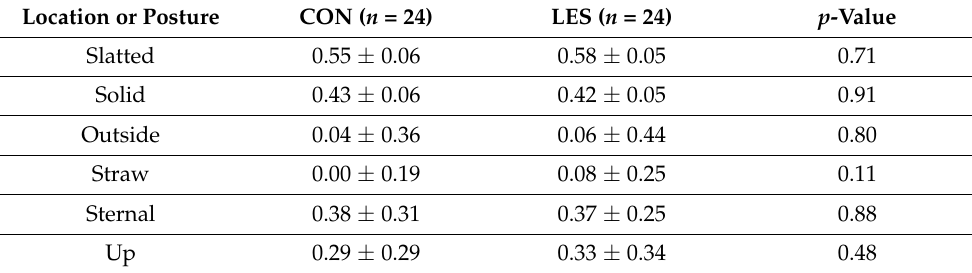
Table 4. Proportion of observations where sows with a shoulder sore (LES) and control sows (CON) were observed on different flooring types, in different areas in the gestation pen, in a sternal position, or standing up at the time of the observation. Sows were observed twice daily after 8 days post- weaning once they were placed in the gestation pen post-breeding. Proportions are means and standard deviations for slatted and solid flooring and are otherwise medians and interquartile ranges. Location or Posture CON ( n = 24) LES ( n = 24) p -Value Slatted 0.55 ± 0.06 0.58 ± 0.05 0.71 Solid 0.43 ± 0.06 0.42 ± 0.05 0.91 Outside 0.04 ± 0.36 0.06 ± 0.44 0.80 Straw 0.00 ± 0.19 0.08 ± 0.25 0.11 Sternal 0.38 ± 0.31 0.37 ± 0.25 0.88 Up 0.29 ± 0.29 0.33 ± 0.34